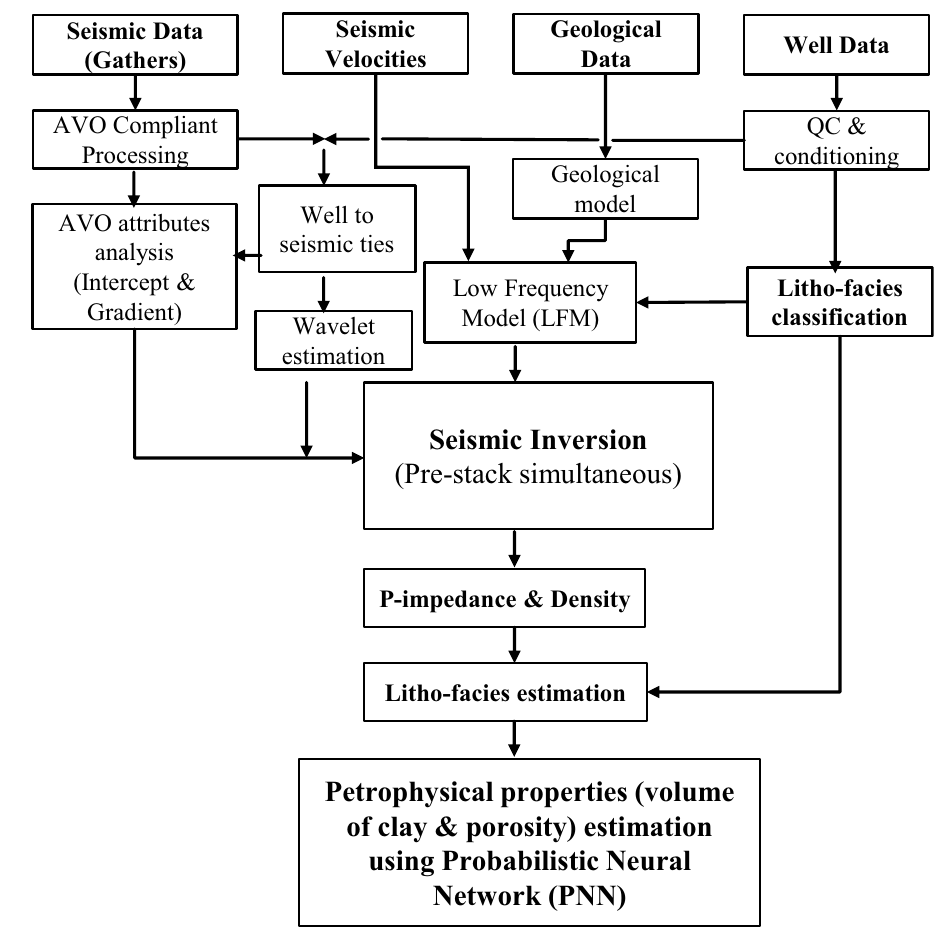
Fig. 3 Integrated quantita- tive geophysical process flow